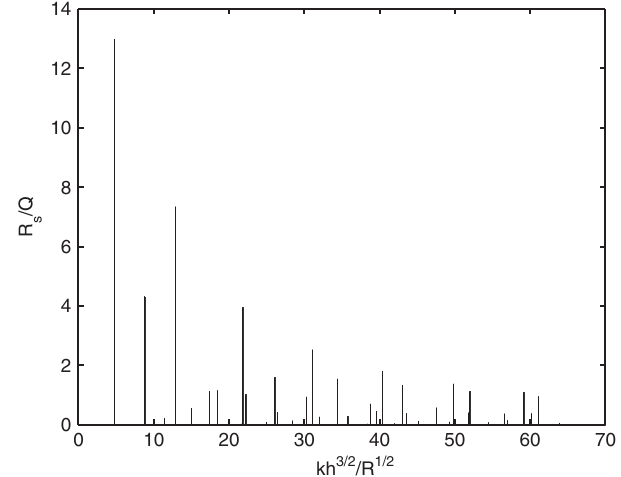
=Q for the resonances as a function s ˆ k for a square chamber.